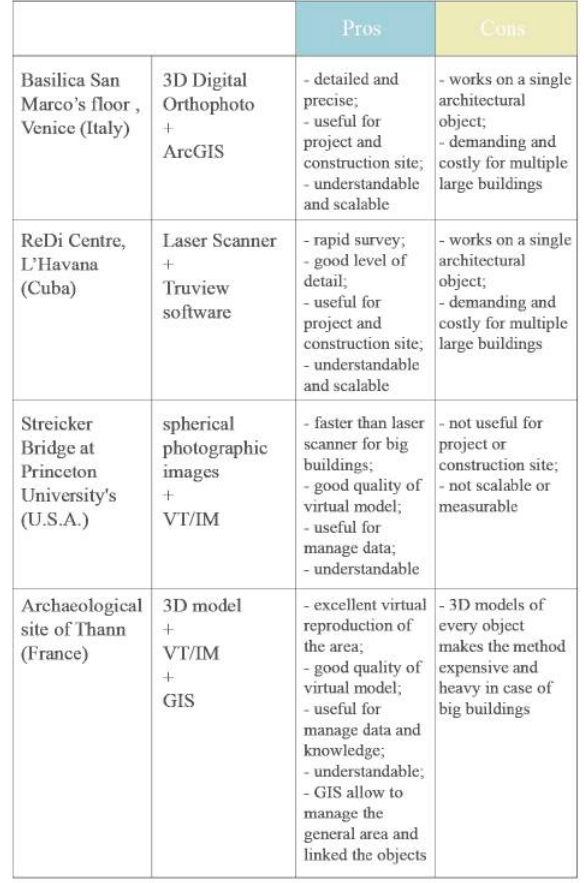
Table 1. Pros and Cons of advanced geomatics for architectural heritage